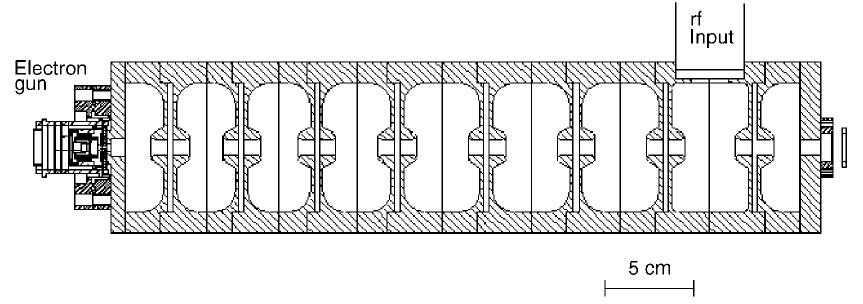
scheme.FIG. FIG. 2. Resonant-charge pulse forming circuit FIG. 3. Typical pulse